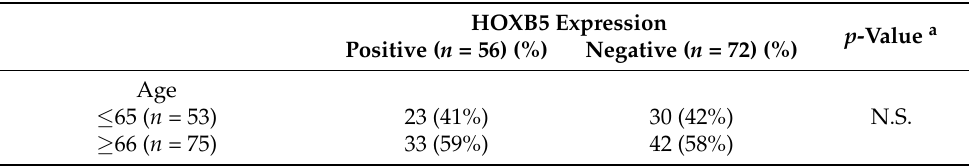
Table 1. Relationship between HOXB5 expression and clinicopathologic characteristics in the 128 pa- tients with prostate